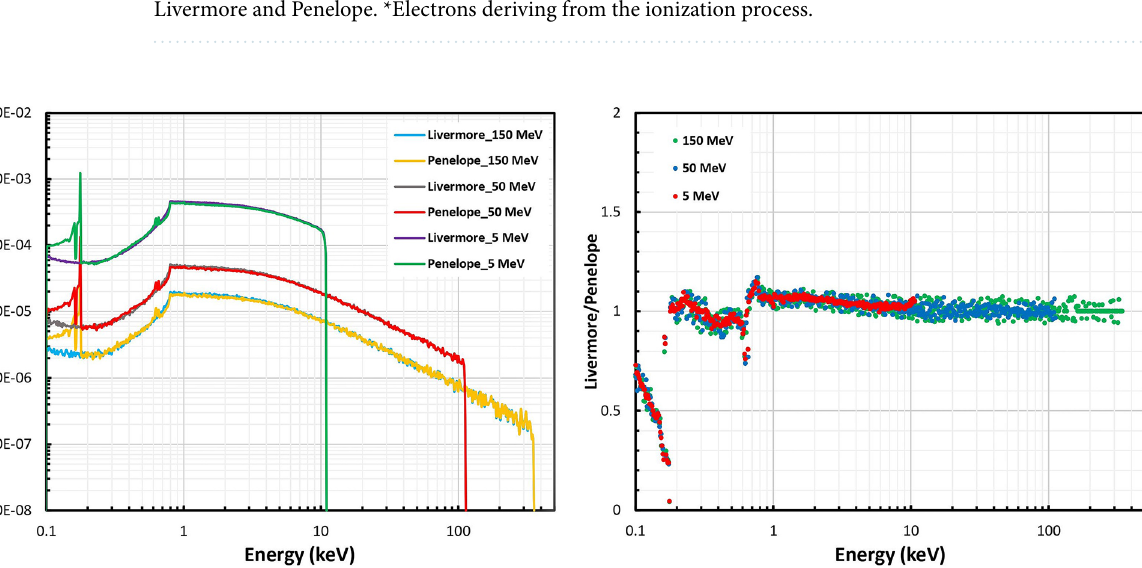
Figure 3. Comparison of the secondary electron spectra around the GNP between the Livermore and Penelope models obtained for 5, 50, and 150-MeV proton beams.